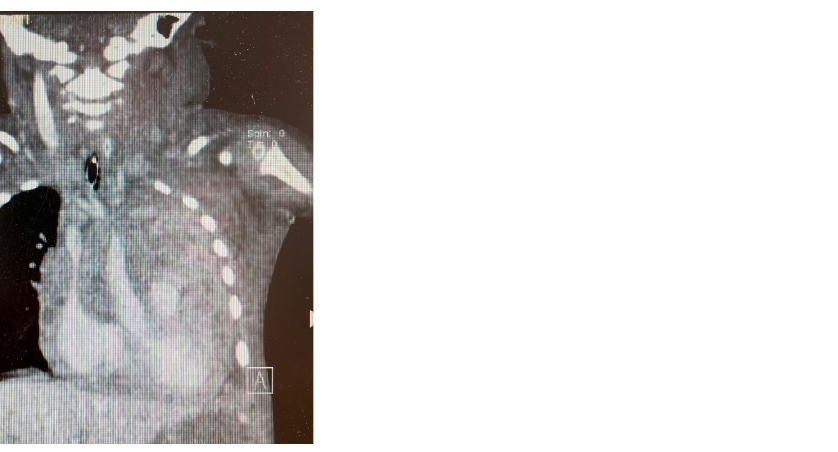
Figure 3. CT: a tumor mass located in the upper and middle anterior mediastinum, fully occupying the retrosternal space with prominent left paramedian extension.